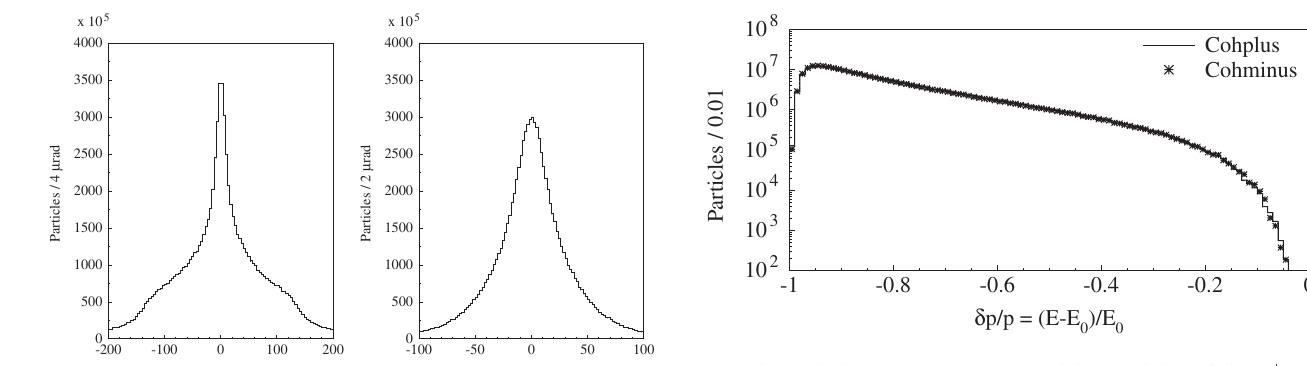
FIG. 5. Relative energy spectrum of the particles of the e þ e (cid:1) coherent pairs with the same charge as the disrupted beam (Cohplus) and with the opposite charge (Cohminus), obtained with GUINEA-PIG using Gaussian incoming beams and normal- ized to one bunch.